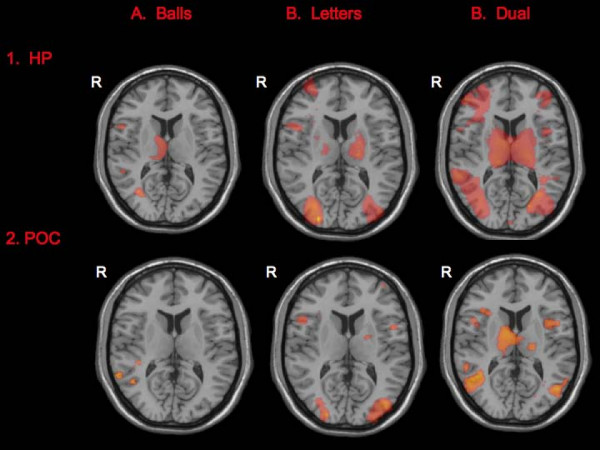
Activation maps per group per attention task. The attention tasks elicited greater response in widespread areas in both the healthy participants (HP) and the presumed obligate carriers (POCs). There were no areas with greater activation during rest compared to the attention trials in either group. Right hemispheric activations are on the left side of the images. For ease of comparison across groups and across tasks, activations are displayed on axial images and thresholded at z = 3.0.